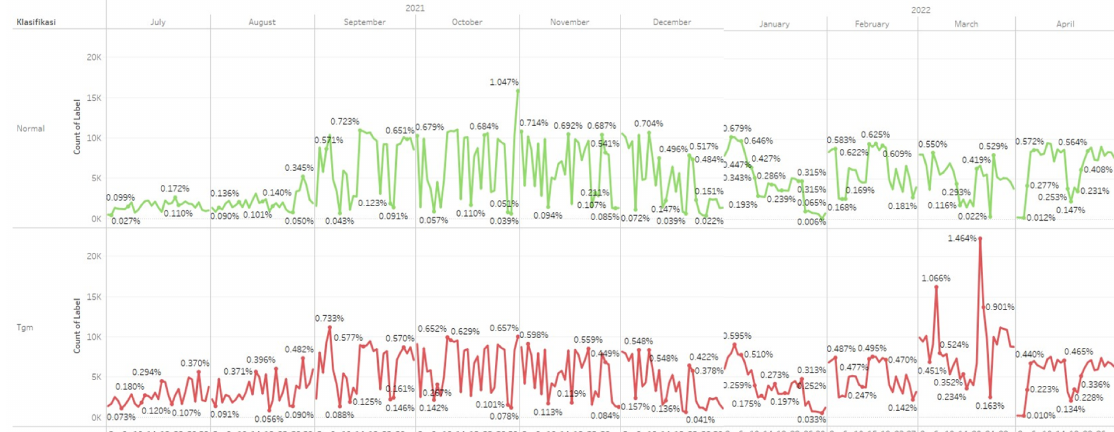
Fig. 3. Line chart classification